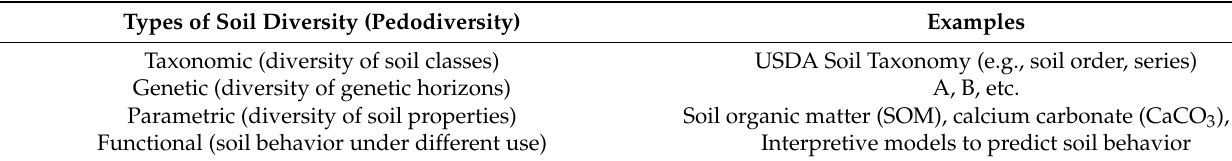
Table 1. Examples of soil diversity (pedodiversity)